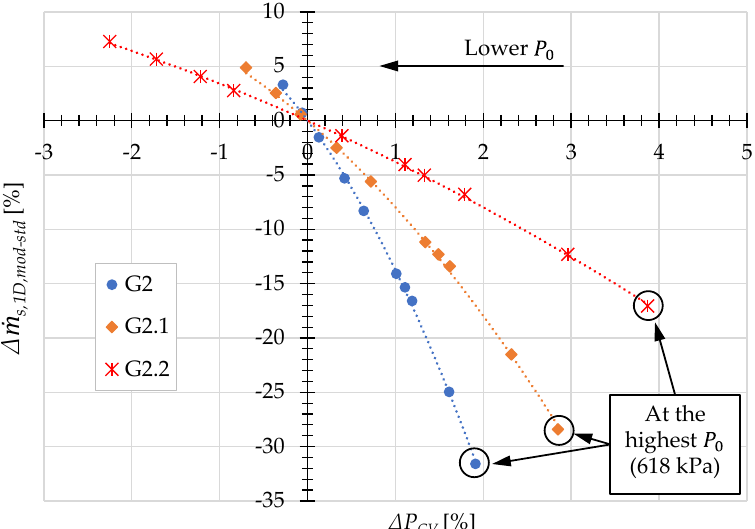
Figure 20. The effect of the converging wall pressure change on the change of the secondary mass flow rate obtained from the one-dimensional model.